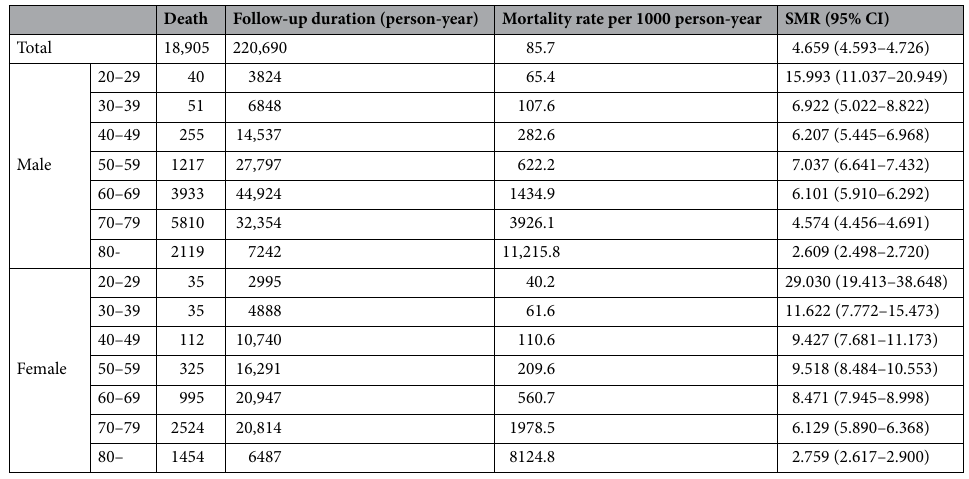
Table 3. Standardized mortality ratio of patients with idiopathic pulmonary fibrosis (IPF) according to age group. IPF idiopathic pulmonary fibrosis, SMR standardized mortality ratio, CI confidence